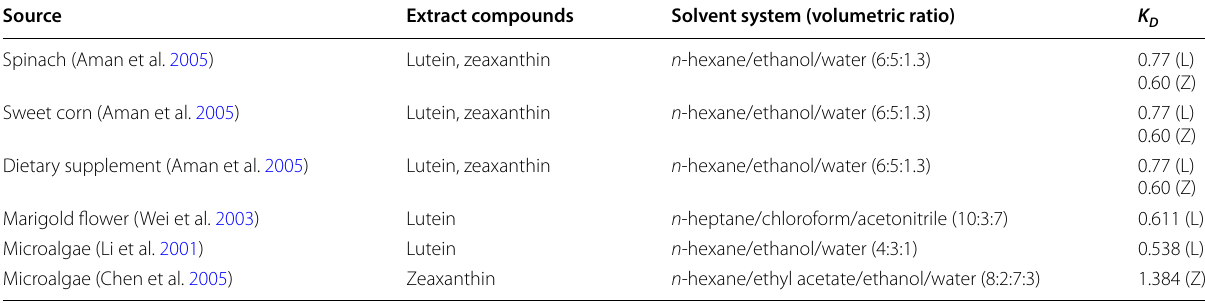
Knowledge of previously used solvent systems aid in selection of a suitable solvent system